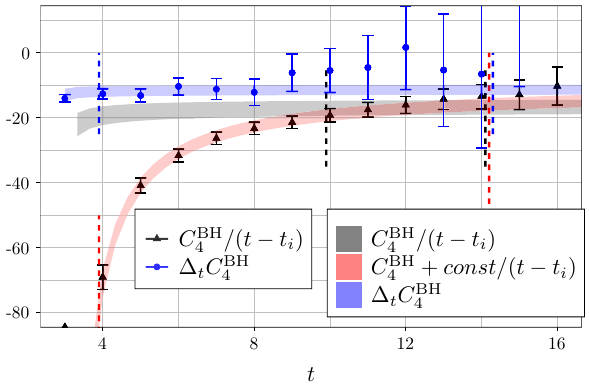
Fig. 1 Four-point function of Eq. (3) multiplied by L 3 / 2, for L = 22 and T = 96 with t i = 3 and t f = 16 divided by ( t − t i ) black triangles. the dashed vertical lines represent the fit interval, the black band represent the result of the fit Eq. (3) and the red band is the same fit with an extra constant term. The blue circles and band represent the discrete derivative of the correlator Eq. (4) and the corresponding fit